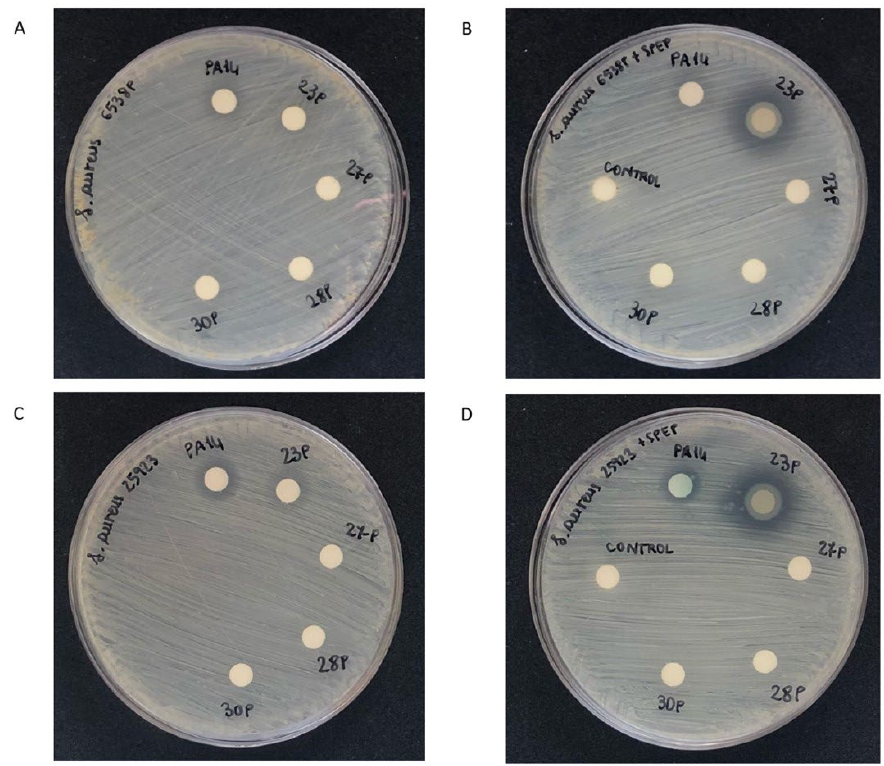
Figure 7. Disk diffusion susceptibility assay of S. aureus growth inhibition by the supernatant of P. aeruginosa treated and untreated with SPEP (Petri plates diameter 8.5). ( A ) Disk diffusion susceptibility assay of S. aureus 6538P containing supernatants derived from P. aeruginosa cultured in BHI. ( B ) Disk diffusion susceptibility assay of S. aureus 6538P containing supernatants obtained from P. aeruginosa cultured in BHI and 200 U/mL SPEP. ( C ) Disk diffusion susceptibility assay of S. aureus 25,923 containing supernatants derived from P. aeruginosa cultured in BHI. ( D ): Disk diffusion susceptibility assay of S. aureus 25,923 containing supernatants derived from P. aeruginosa cultured in BHI and 200 U/mL SPEP. Control disk contains 200 U/mL SPEP.